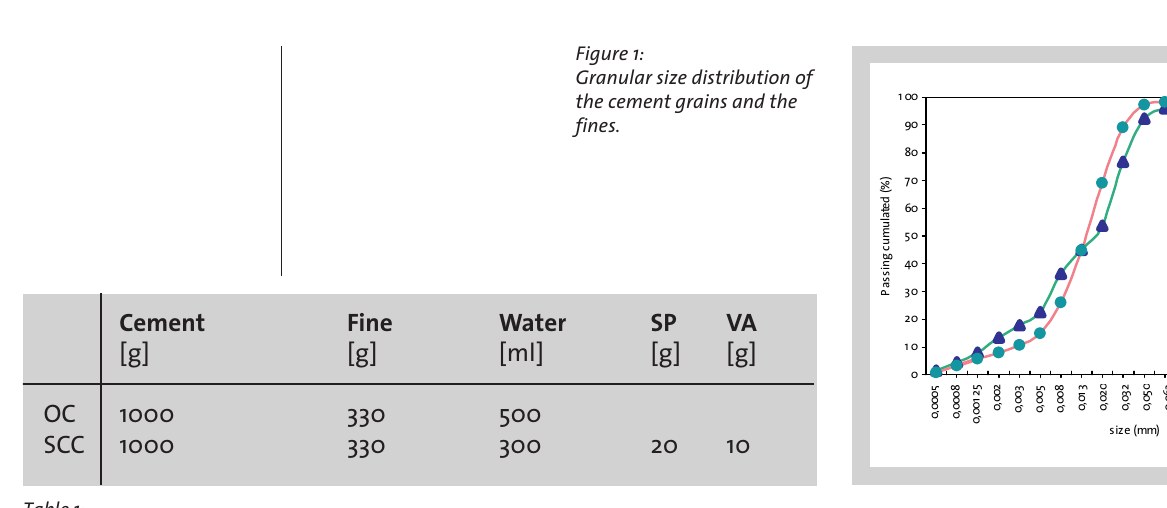
Table 1: a) Composition of the ordinary cement paste (OC), b) Composition of the self-compacting concrete paste (SCC).